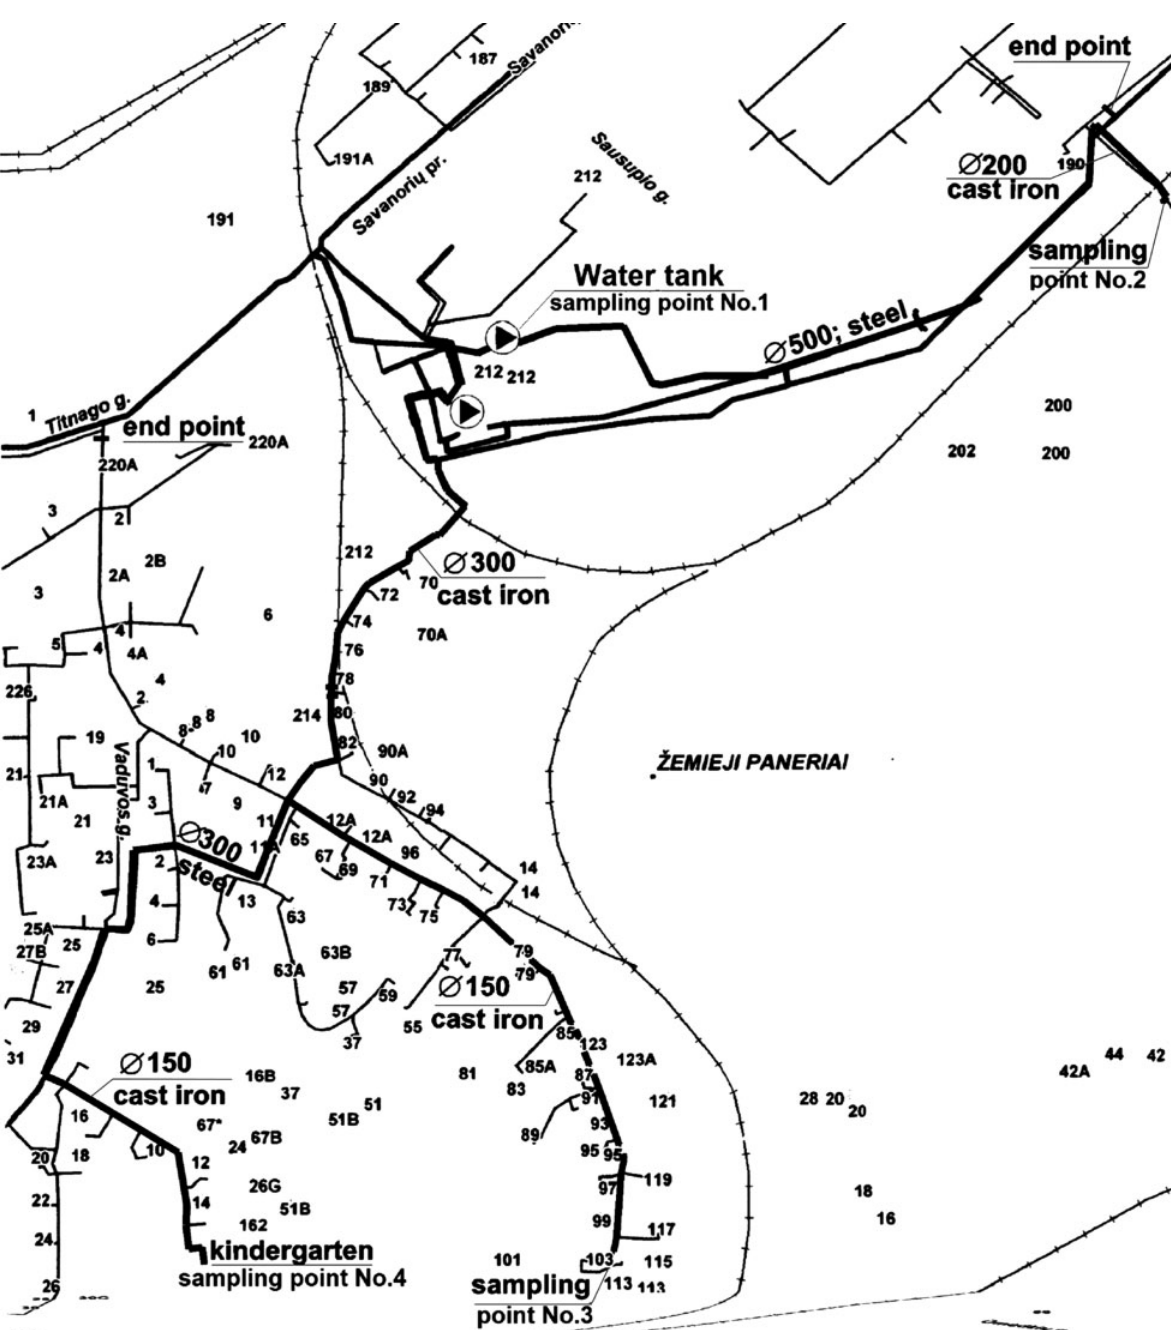
Fig. 1. Sampling scheme of Vilnius water supply network